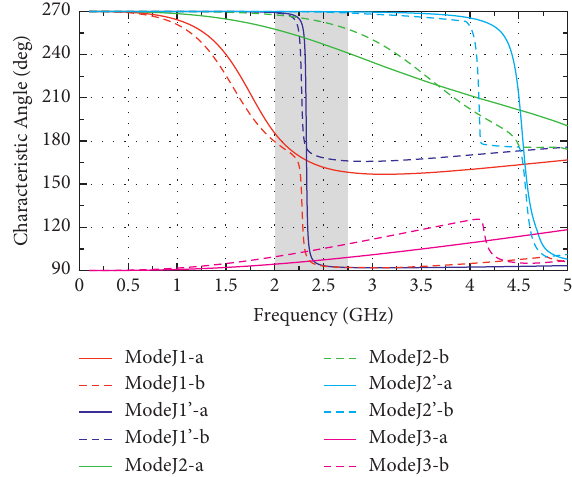
Figure 3: Characteristic angle associated to the first five modes of the structure shown in Figure 2. Mode-a case 1: parallel plates with the same dimensions. Mode-b case 2: parallel plates with different